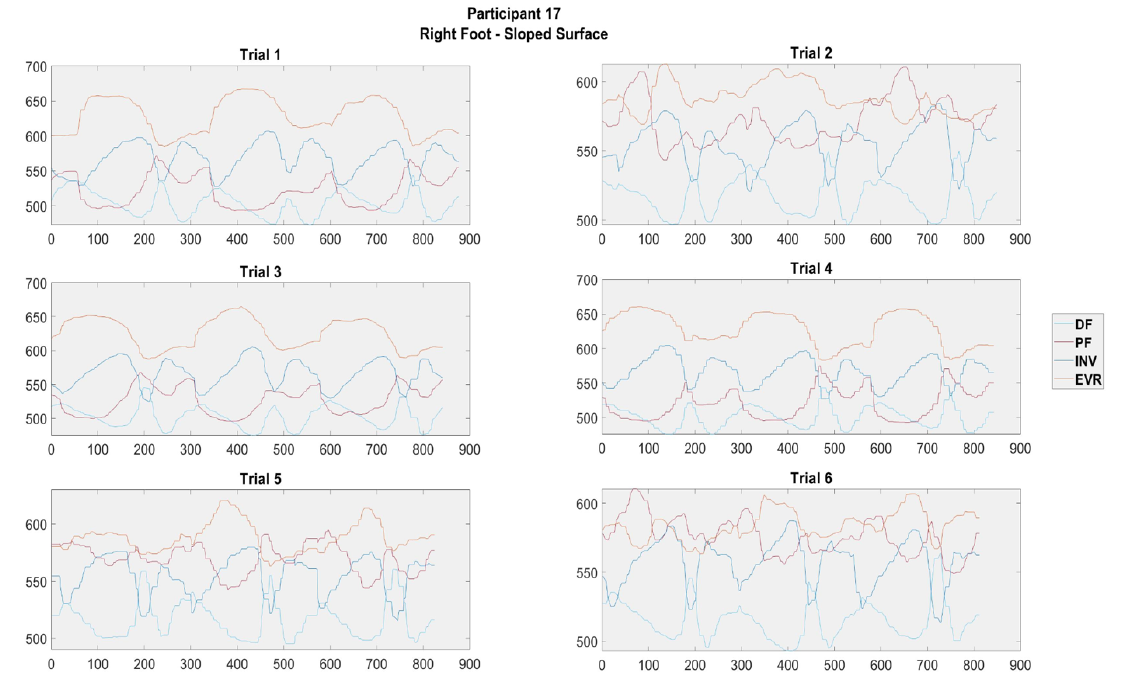
Figure 7. Data from the right foot SRS in the sloped surface experiment performed by participant 17.